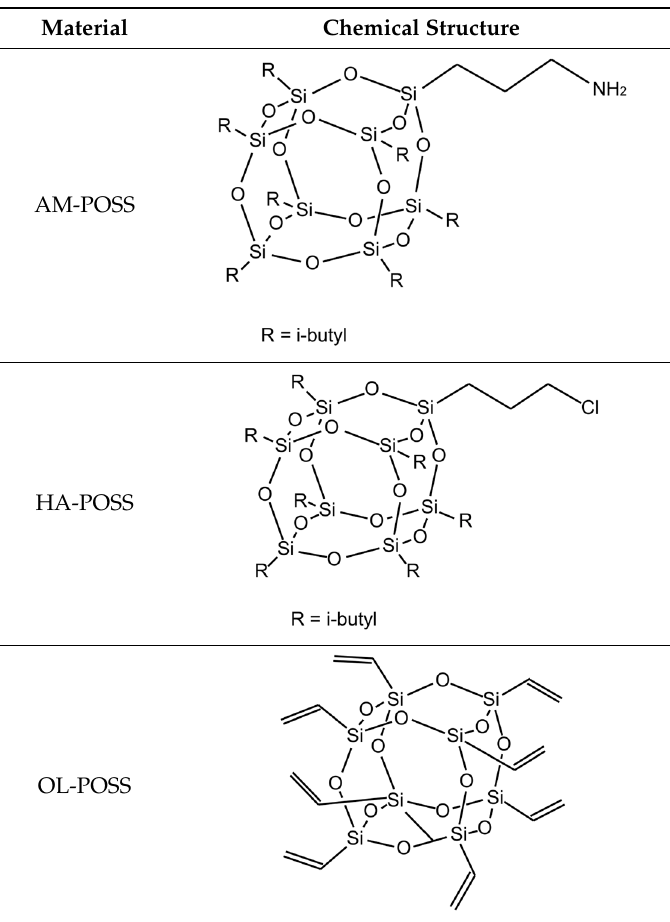
Table 1. Chemical structure of POSS nanoparticles.